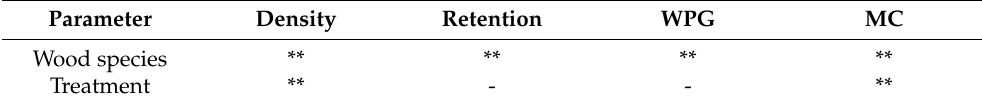
Figure 3. The density of each wood specimen according to treatment. Table 3. Variance analysis summary of density, WPG, retention, and MC.